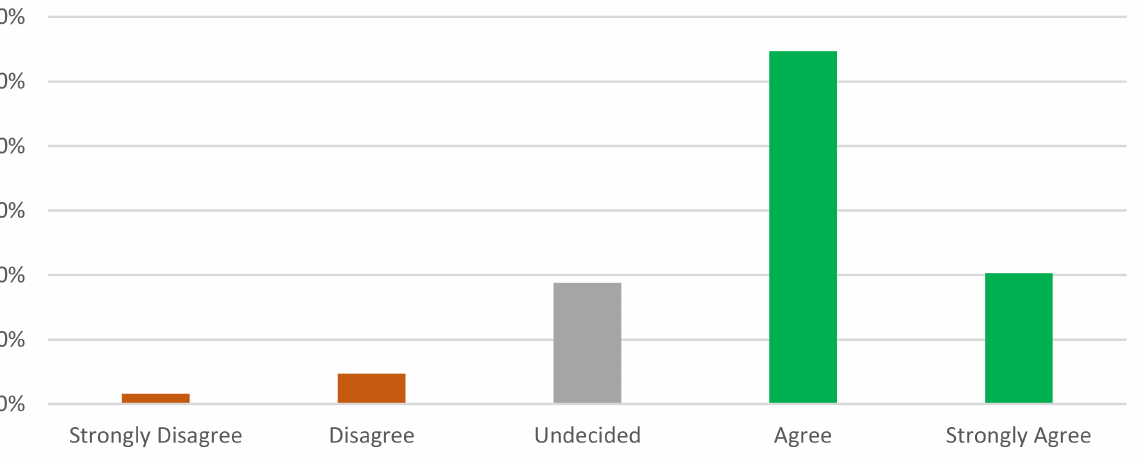
Figure 5. Responses to the suitability of the PHARM